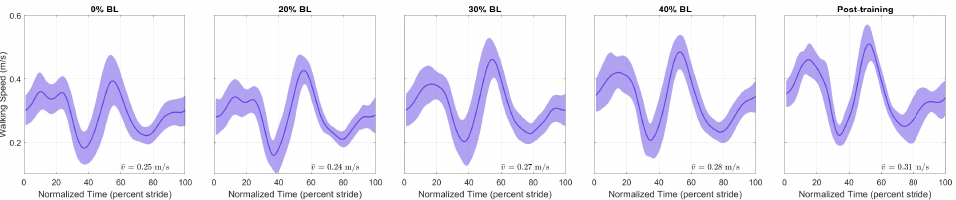
Figure 15. Speed profiles of the stroke survivor participant. Each stride starts at paretic HS and ends at the next paretic